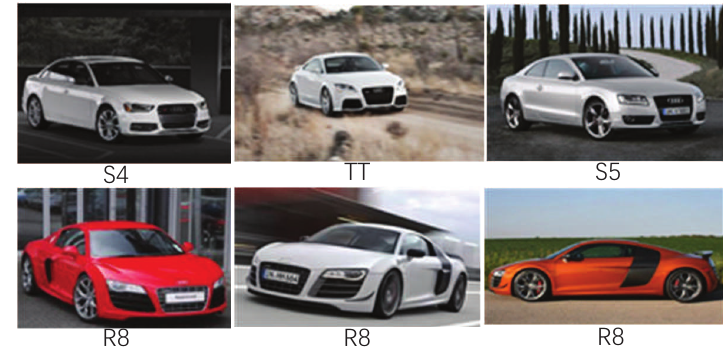
Figure 1. Sample examples on Stanford